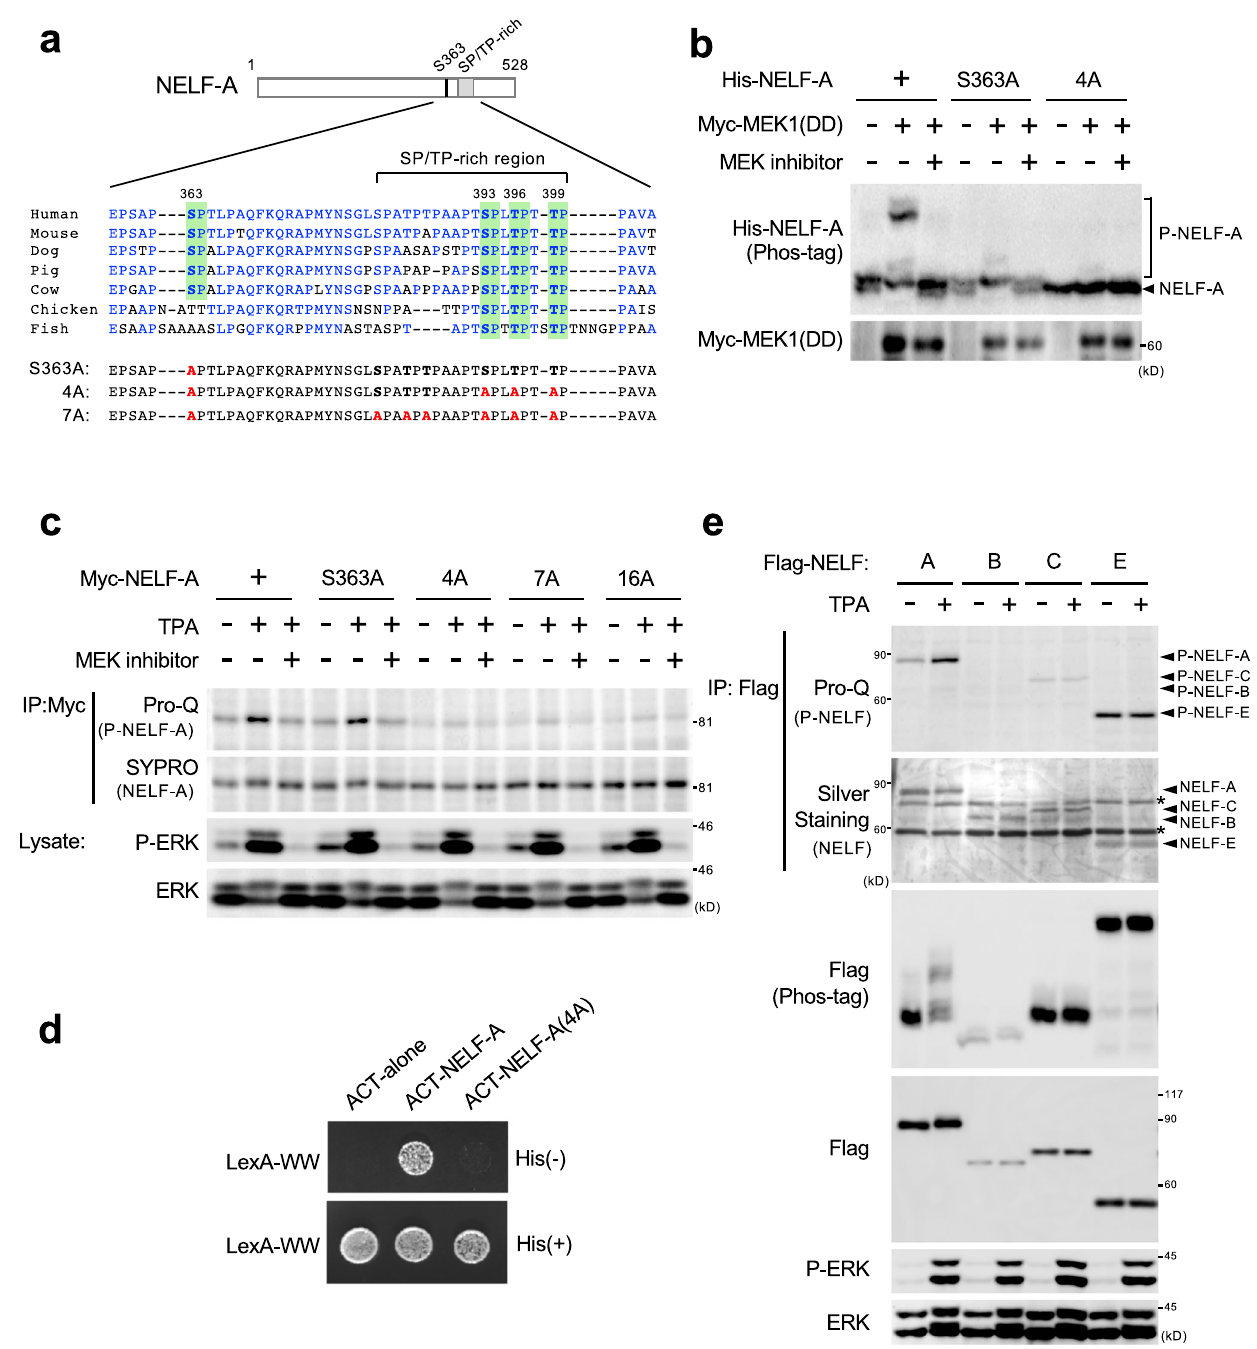
Fig. 2 | ERK phosphorylates NELF-A at evolutionarily conserved Ser and Thr residues. a Sequence alignments of various NELF-A orthologues. Conserved resi- dues are shown in blue. Green boxes, ERK phosphorylation sites (SP and TP). The Ser/Thr residues in which Ala substitution mutations were made (S363A, 4A, and 7A) are indicated. b HEK293 cells were cotransfected with His-NELF-A (WT, S363A, or 4A) and Myc-MEK1(DD), and treated with (+) or without ( − ) the MEK inhibitor (trametinib). Phosphorylation of His-NELF-A was analyzed by Phos-tag SDS-PAGE and immunoblotting using an anti-His antibody (upper). The expression level of Myc-MEK1(DD) in the cell lysates is also shown (lower). c HEK293 cells expressing Myc-NELF-A or its mutant derivatives (S363A, 4A, 7A, or 16A) were pretreated with orwithoutaMEKinhibitor(AZD6244,10 µ M)andstimulatedwithTPA(300nM,for 15min). The phosphorylation status of immunoprecipitated Myc-NELF-A was assessed by ProQ diamond gel staining (top), and total Myc-NELF-A was